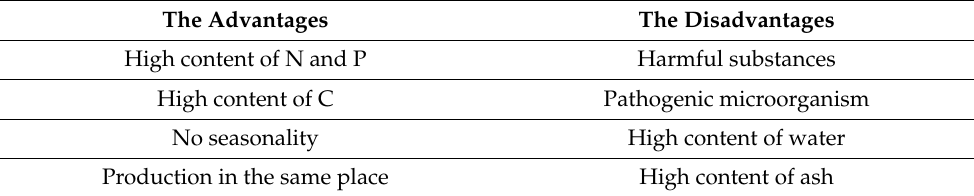
Table 2. General advantages and disadvantages of sewage sludge